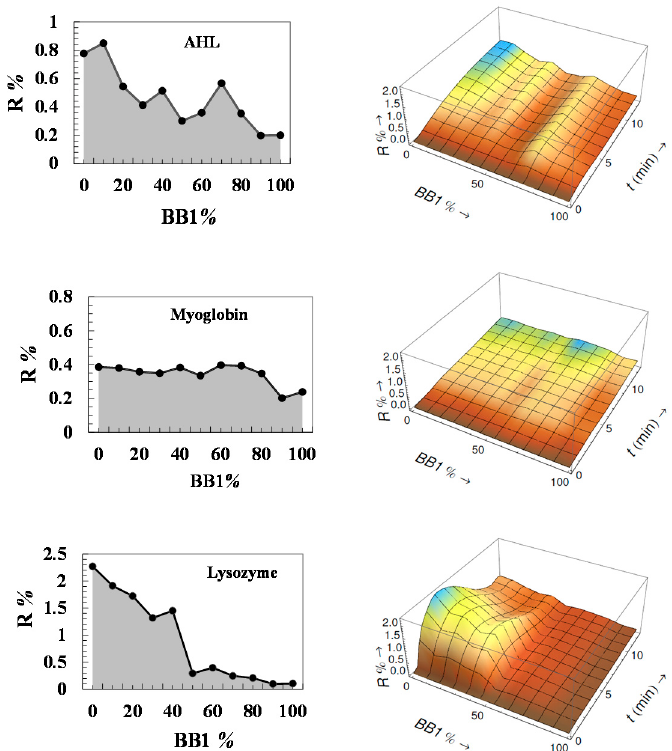
Figure 3. Analysis of common proteins by the eT: CEPs and CELs of Arachis hypogaea lectin (AHL) (500 nM), myoglobin (1 µM), and lysozyme (500 nM). Adapted from [30] with permission from JoVE.